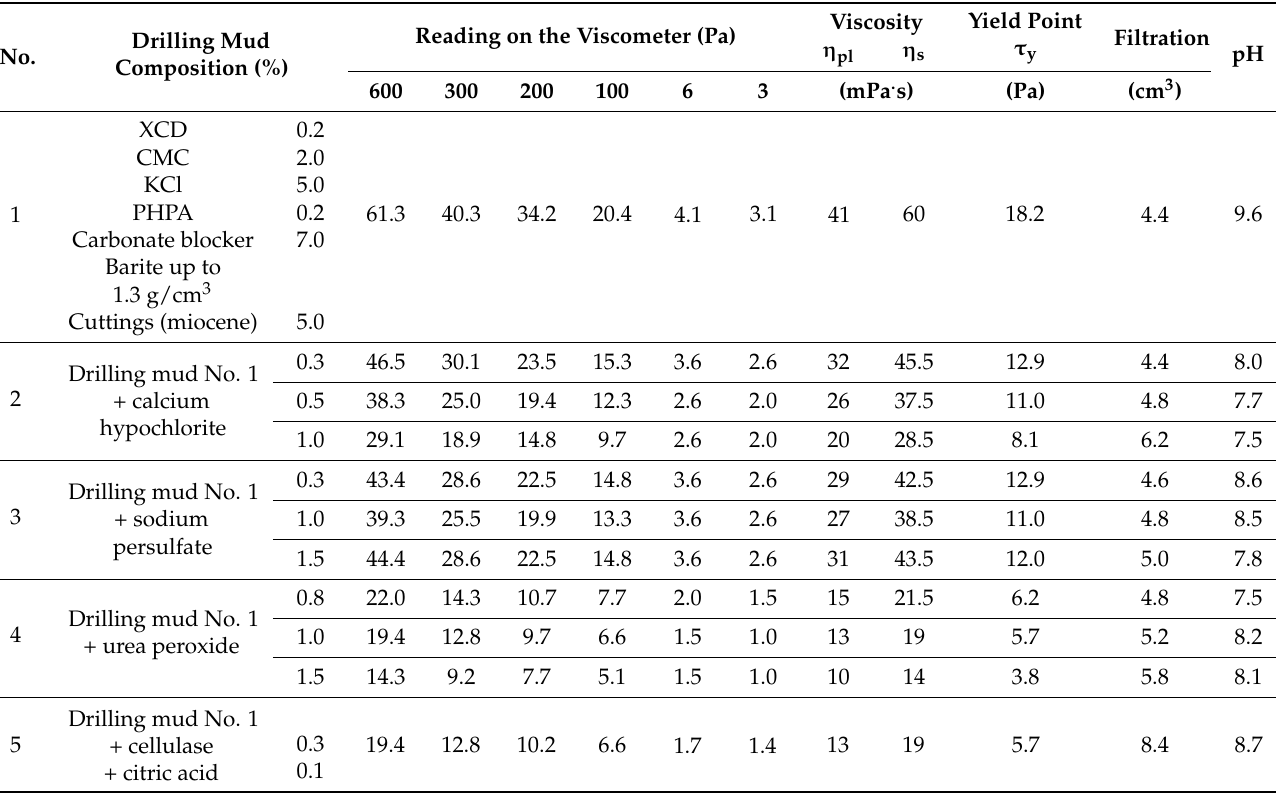
Table 3. The properties of potassium-polymer drilling mud B with the addition of oxidizing agents and cellulase.